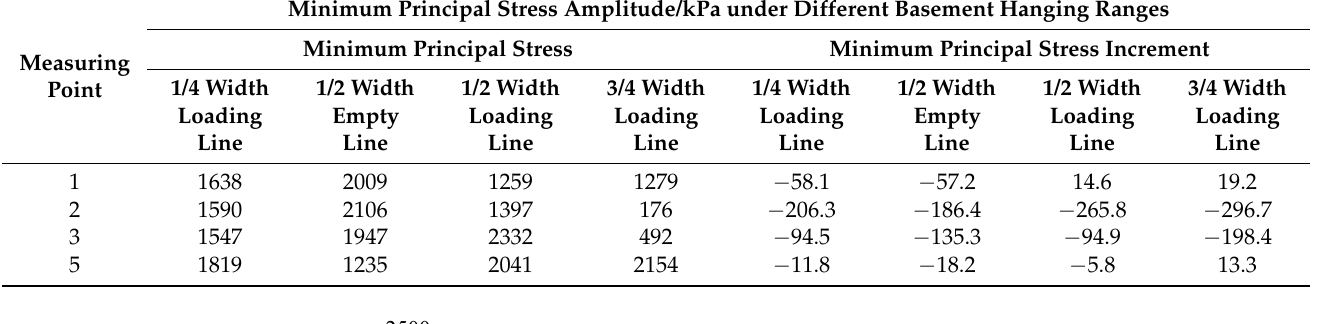
Figure 17. Maximum principal stress amplitude diagram of measuring points 1, 2, 3, and 5 under different basement hanging ranges. Table 15. Maximum principal stress amplitude of measuring points 1, 2, 3, and 5 under different basement hanging ranges.